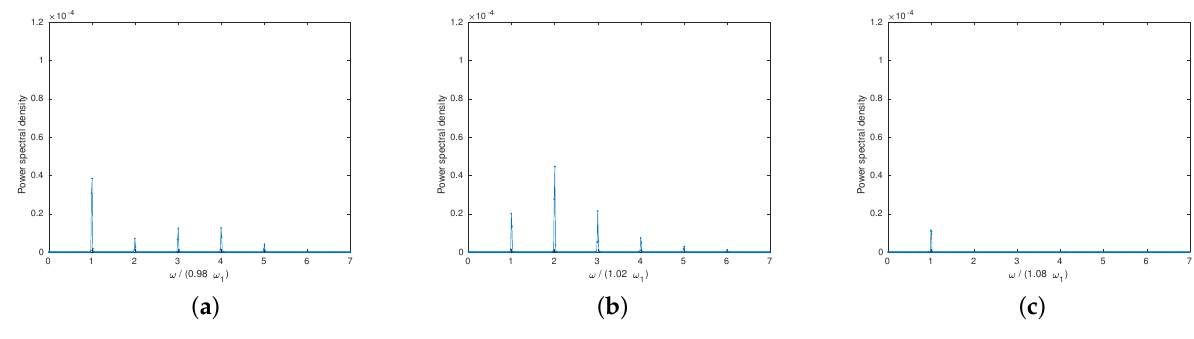
Figure 7. The frequency spectrum of pure sway cases under different excitation frequencies: ( a ) ω / ω 1 = 0.98; ( b ) ω / ω 1 = 1.02; ( c ) ω / ω 1 = 1.08.